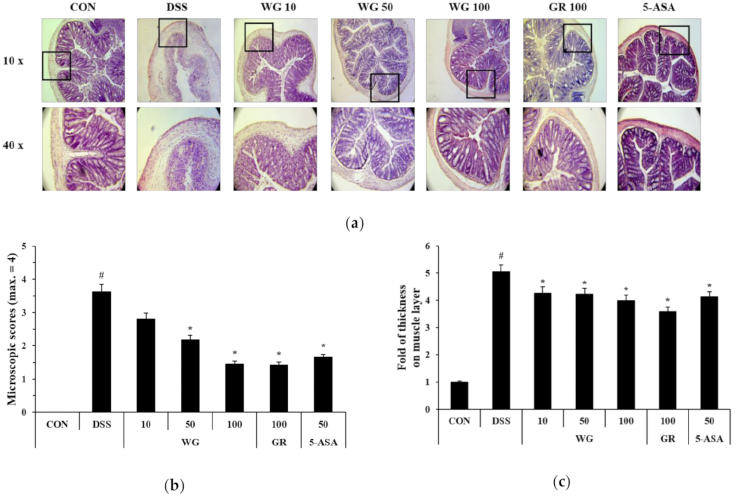
Figure 6. Effect of WG and GR extracts on epithelial injury in mice with DSS-induced colitis. Over the same period, WG (10, 50, and 100 mg/kg), GR (100 mg/kg), and the positive control 5-ASA (50 mg/kg) were orally administered once a day. ( a ) Colon tissue paraffin sections stained with hematoxylin and eosin (H&E) were observed under a microscope (10 × and 40 × ). ( b ) Histological score was measured from the colon tissues on Day 12. ( c ) The thickness of muscle in the colon sections was evaluated using Optiview 3.7 software. The stained sections were observed under a microscope. Values are mean ± SEM (#: p < 0.05 vs. control; *: p < 0.05 vs. DSS